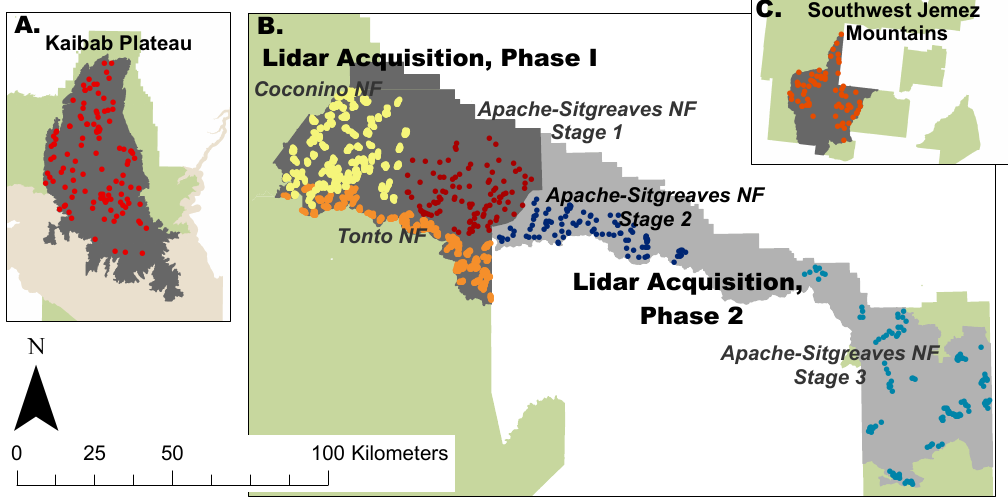
Figure 2. Map of the seven field data collection efforts and the footprint of the four lidar acquisitions, in grey, subset by region. Plots used for model development are displayed in warm tones (red, orange, yellow); those used to assess transferability of model are blue. The three regions where data collection took place include: ( A ) Kaibab Plateau, AZ; ( B ) Four Forest Restoration Initiative, AZ, and ( C ) Southwest Jemez Mountain Landscape Restoration,